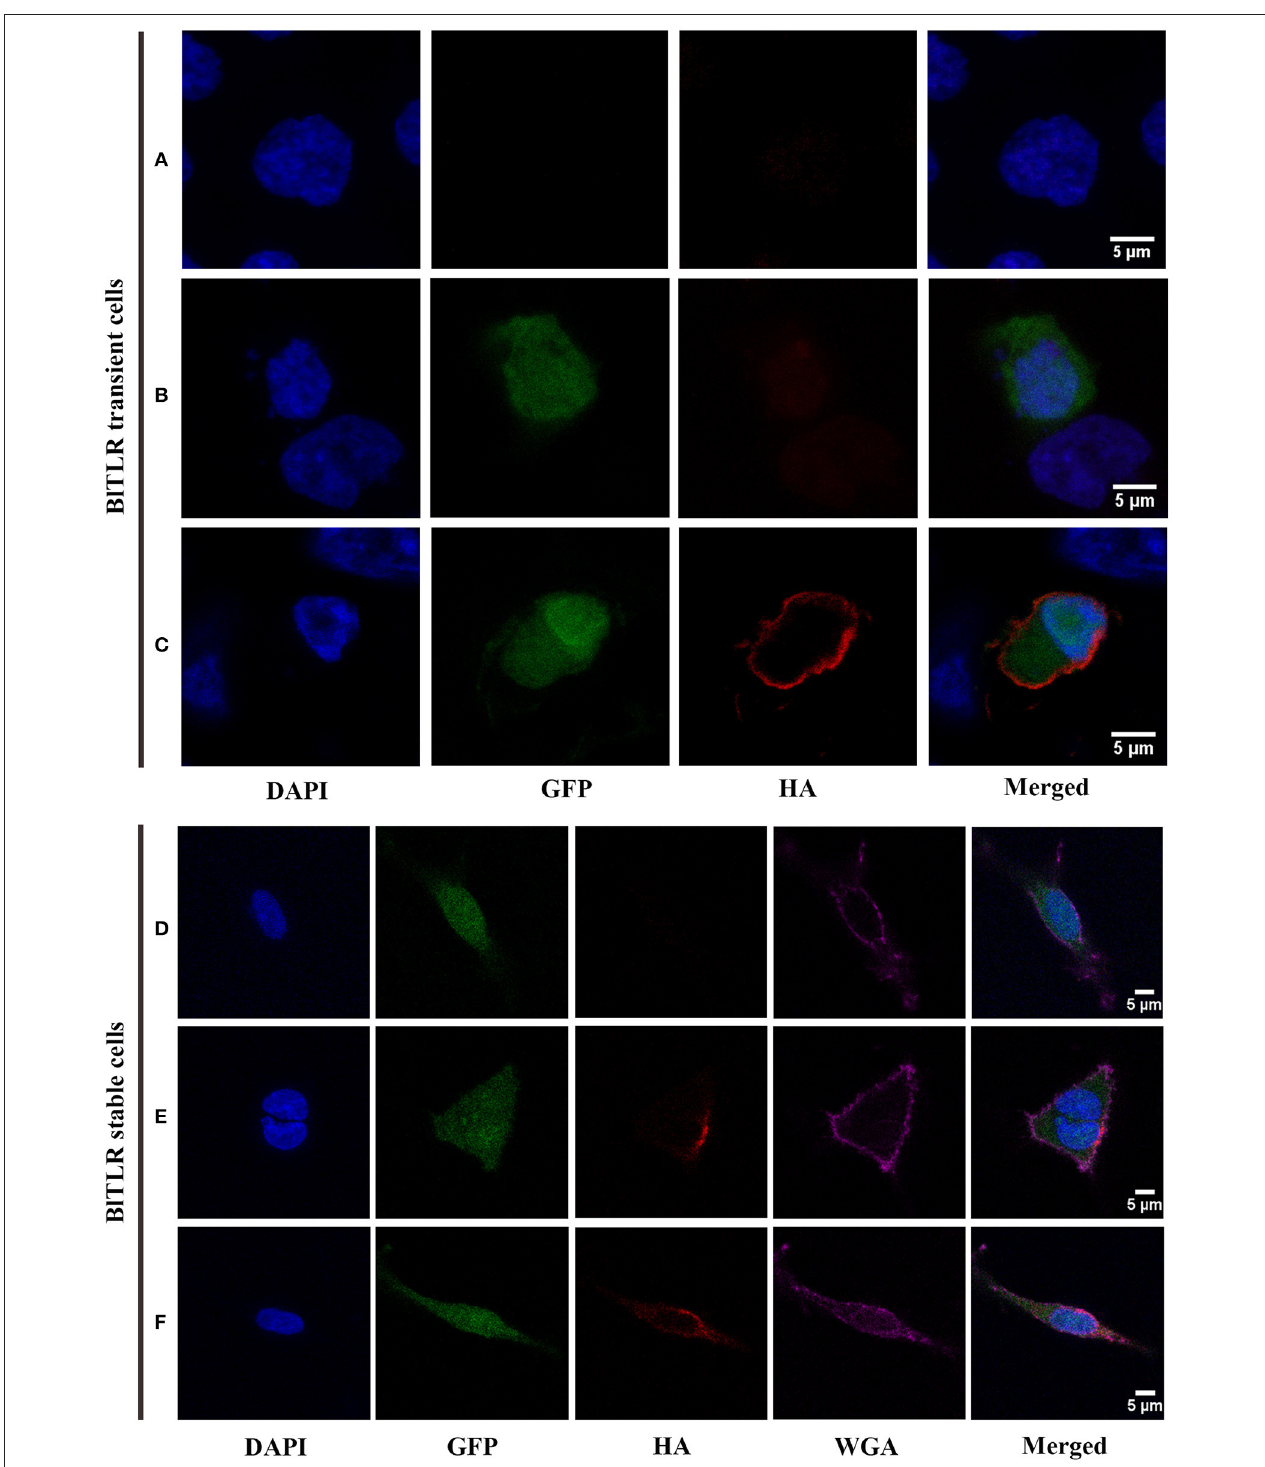
FIGURE 5 | Subcellular localization of BlTLR in HEK293 cells. Confocal images showing HEK293 cells transiently transfected (A–C) or stably transfected (D–F) with BlTLR. (A) Not transfected cells; (B) Cells transfected with BlTLR and non-permeabilized; (C) Cells transfected with BlTLR and permeabilized with 0.2% Triton X-100. (D) BlTLR stable cells not permeabilized; (E) BlTLR stable cells permeabilized using freeze and thaw protocol; (F) BlTLR stable cells permeabilized with 0.1% Tween-20. Nuclei are stained with DAPI (in blue). Transfected cells were GFP labeled (in green). BlTLR was detected with anti-HA antibody and AF555-conjugated anti-mouse IgG (in red). Plasma membrane was stained with WGA AF647 conjugated (in purple). Figures were analyzed with Fiji software.